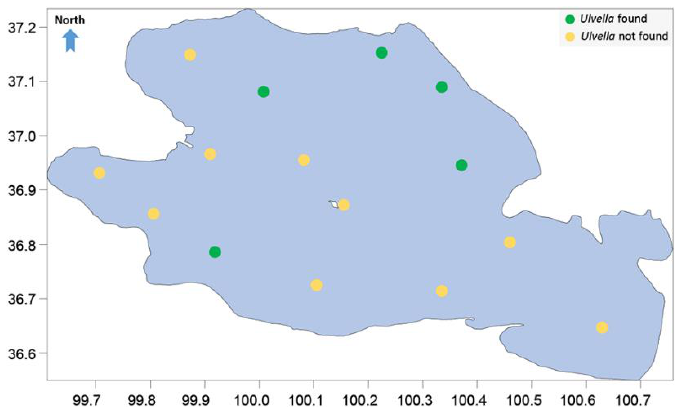
Figure 1. The distribution of the sample points in Qinghai Lake. Average depth, 21 m. Table 1. Main habitat information and physical and chemical indicators of sampling sites. The algal strains of QHH-4, QHH-5, and QHH-15 were successfully cultured. DO: dissolved oxygen; EC: electric conductivity; TDS: total dissolved solid; SAL: salinity; SD: Secchi depth.